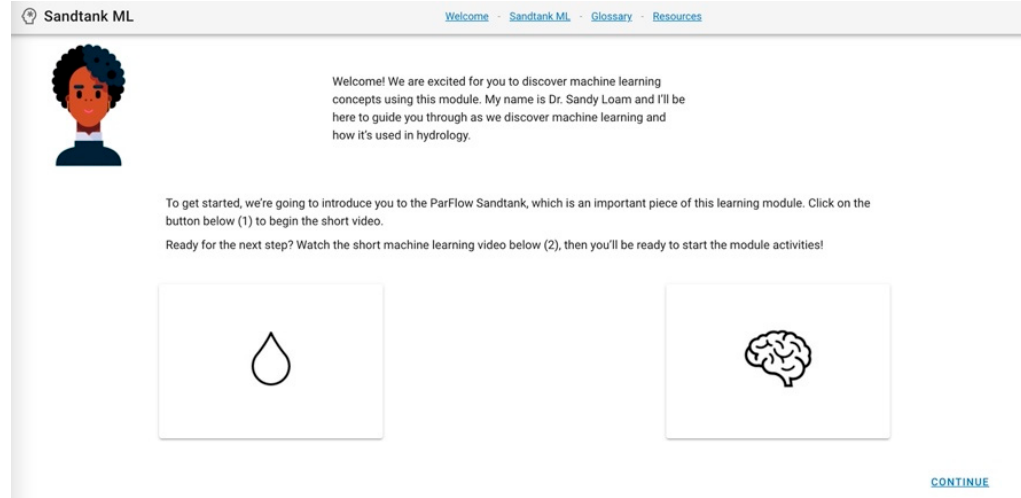
Figure 1. Welcome page of the Sandtank-ML application.